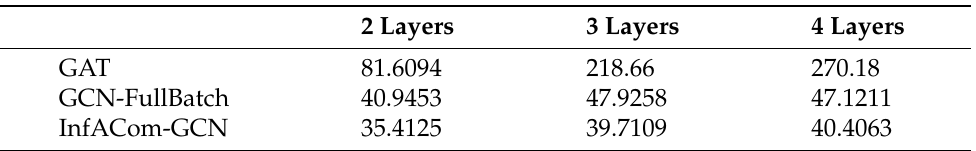
Table 4. Memory usage in megabytes for PubMedDiabetes dataset using different numbers of layers (the number of hidden units is 128).